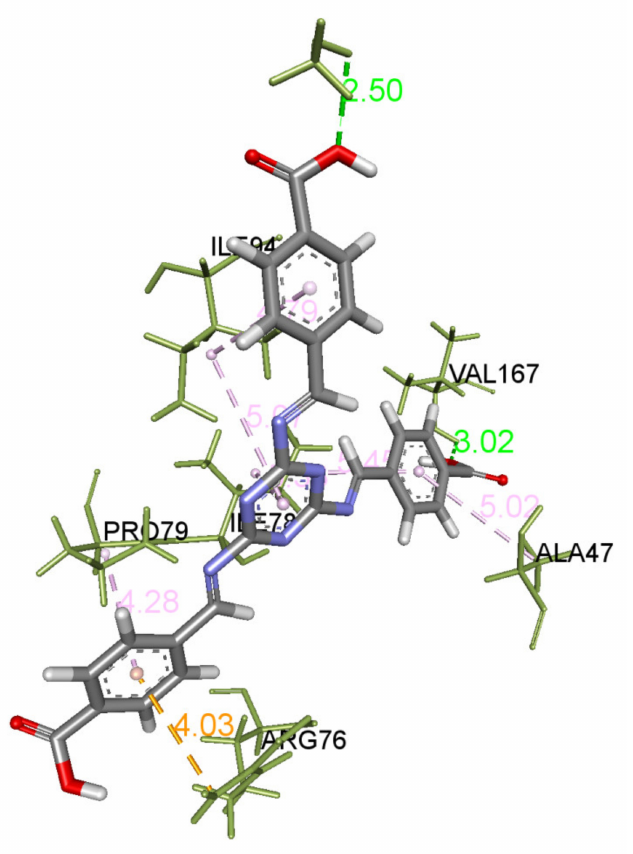
Figure 2. Binding interactions of MT with amino acid residues of E. coli DNA gyrase (5MMN). Key to bond type: orange dotted line = pi-cation bond; green dotted lines = H-bond; purple dotted line =